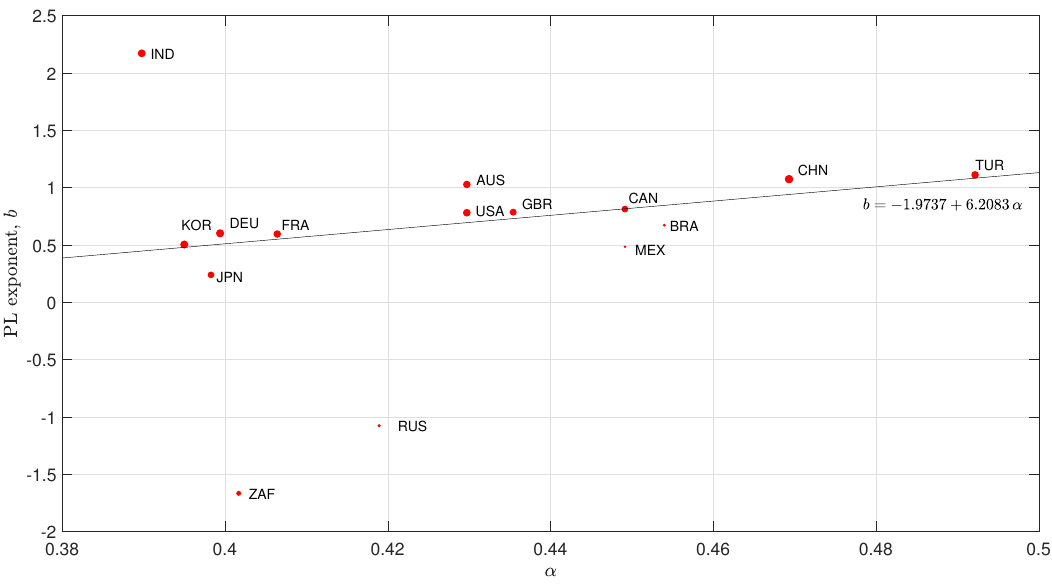
Figure 5. The locus of parameters b versus α . The markers’ size is proportional to the coefficient of determination R 2